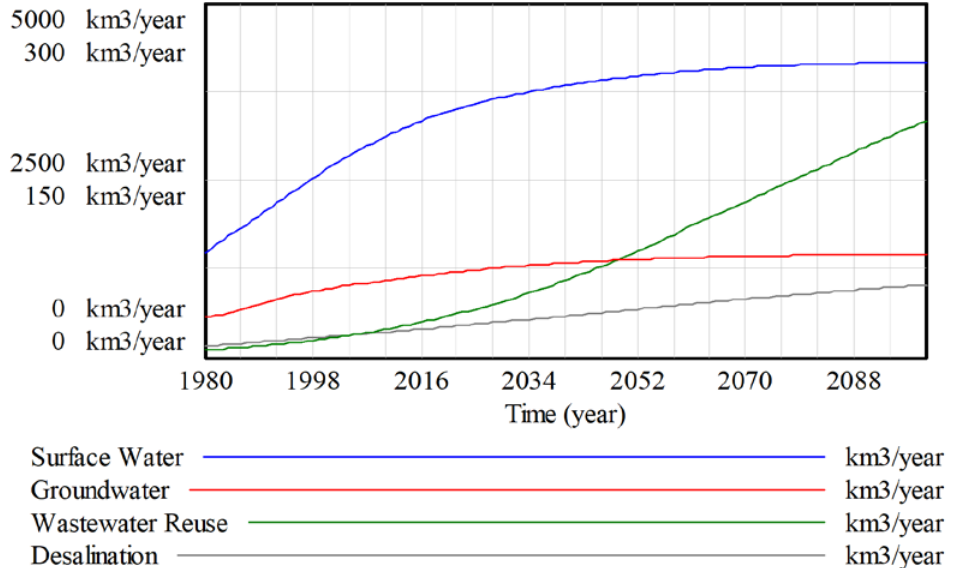
Figure 7. Development of water supplies in the ANEMI3 model. The upper scale labels are used for surface water and groundwater supply while the lower labels are for wastewater reuse and desalination.